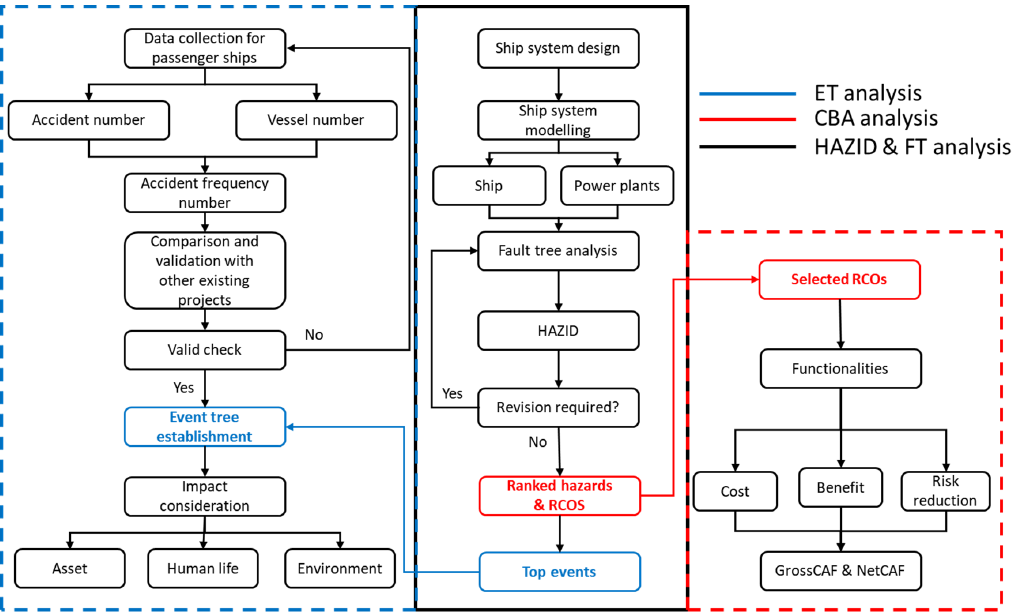
Figure 3. Overview of approaches relationships: hazard identification (HAZID), fault tree analysis (FTA), event tree analysis (ETA) and cost benefit analysis (CBA).